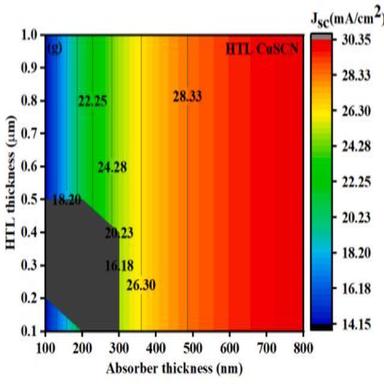
Contour mapping of Jsc for FASnI3 absorber and HTLs thickness (a) CBTS (b) CFTS (c) Cu2O (d) CuI (e) CuO (f) CuSbS2 (g) CuSCN.